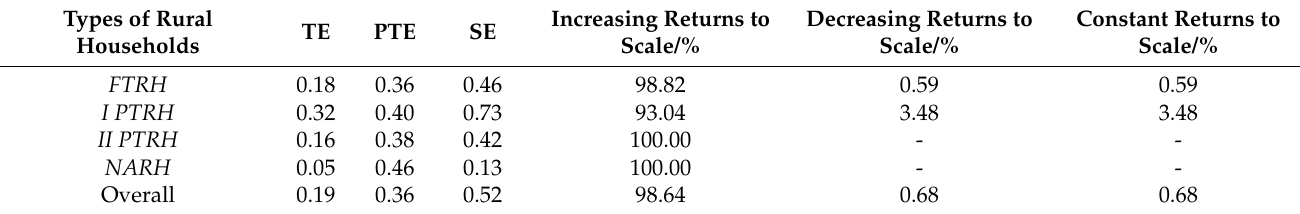
Table 5. CLUE and scale payoff for different rural household